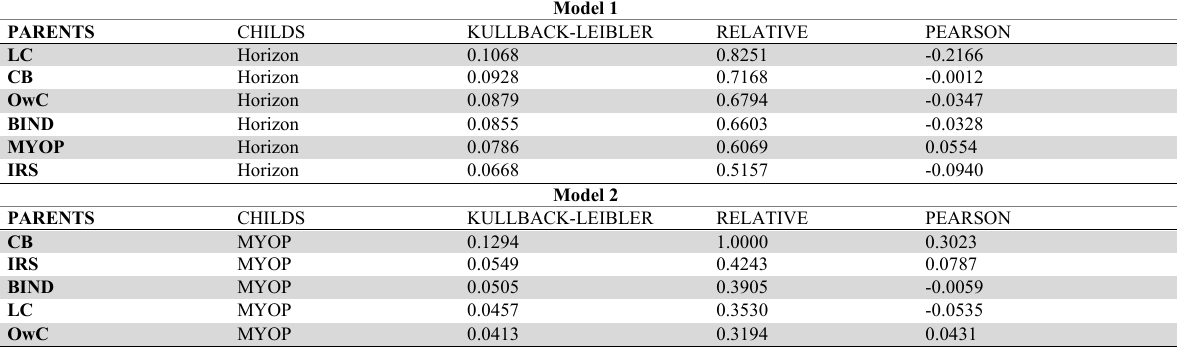
The relationships